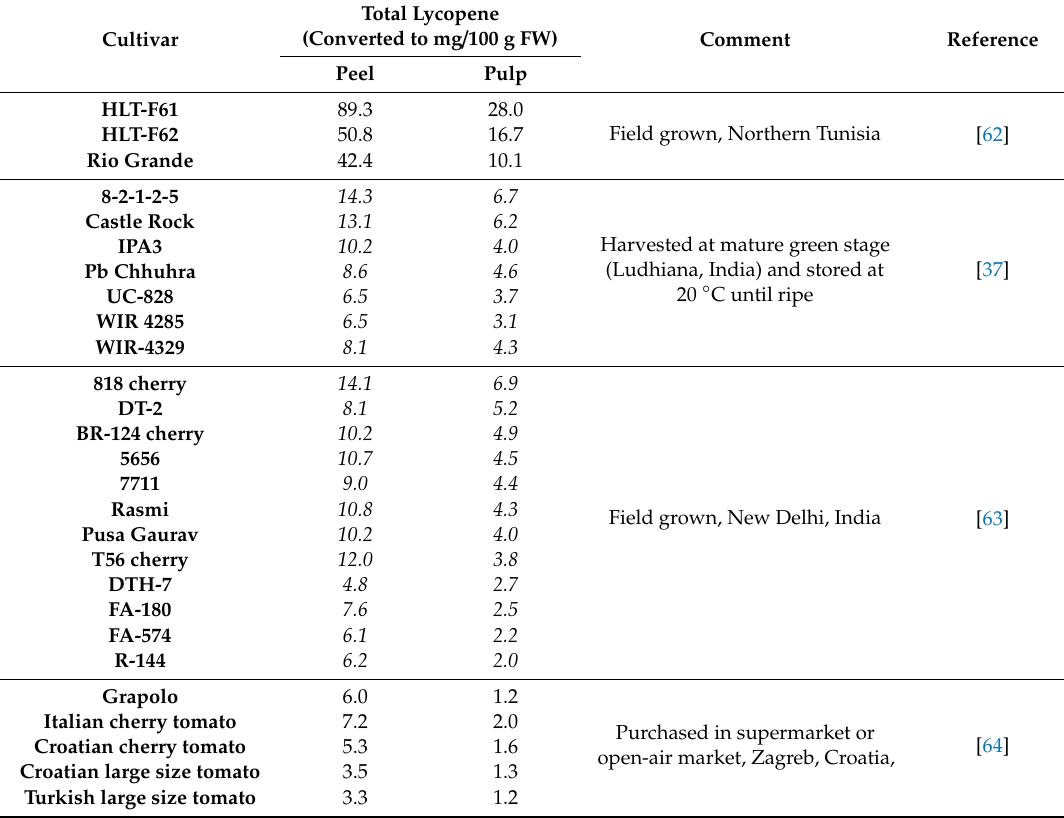
Table 2. Lycopene content in peel versus pulp in some tomato varieties (converted to mg / 100 g FW). Literature review. Values in italics are obtained by spectrophotometry, otherwise